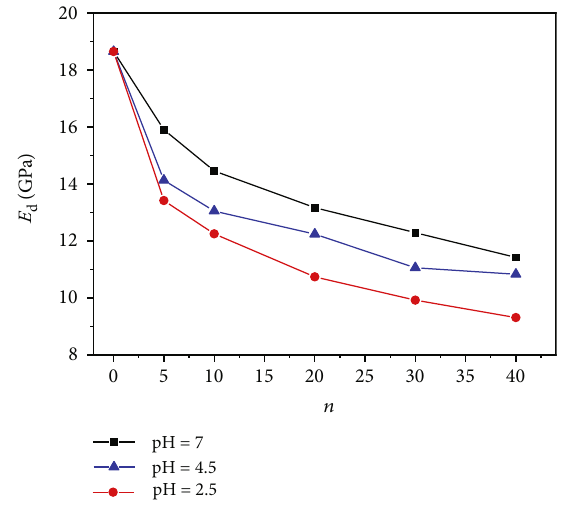
Figure 5: Variation of dynamic elastic modulus of red sandstone under di ff erent environments.